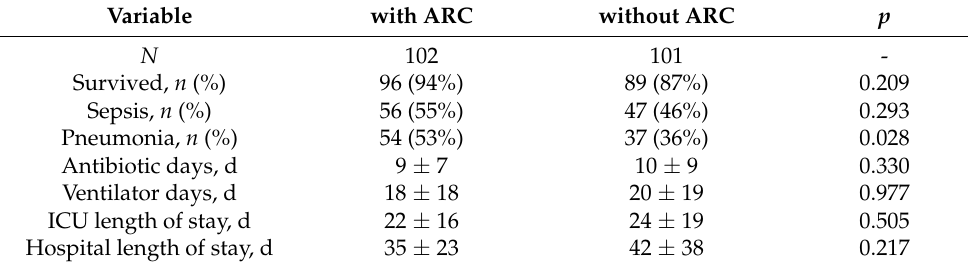
Table 3. Clinical outcomes.